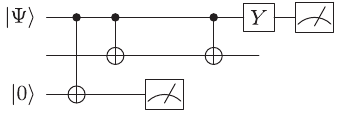
FIG. 8. Quantum circuit to measure the current operator − c † i ð c † c c , as described in the main text. Here, the top j i Þ i j two qubits are the qubits corresponding to the physical sites i and j , and the bottom qubit is an ancilla